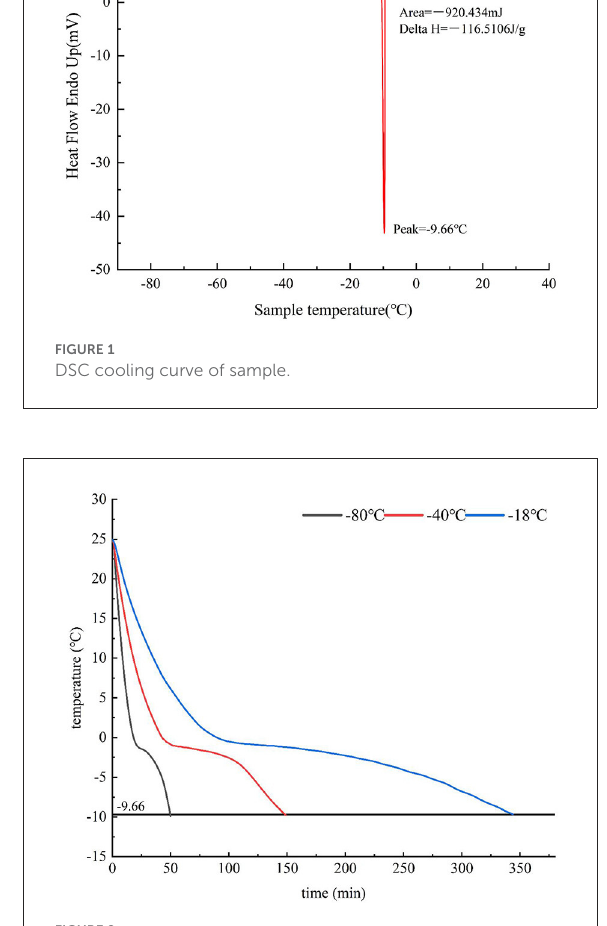
FIGURE2 Freezing curves of different freezing